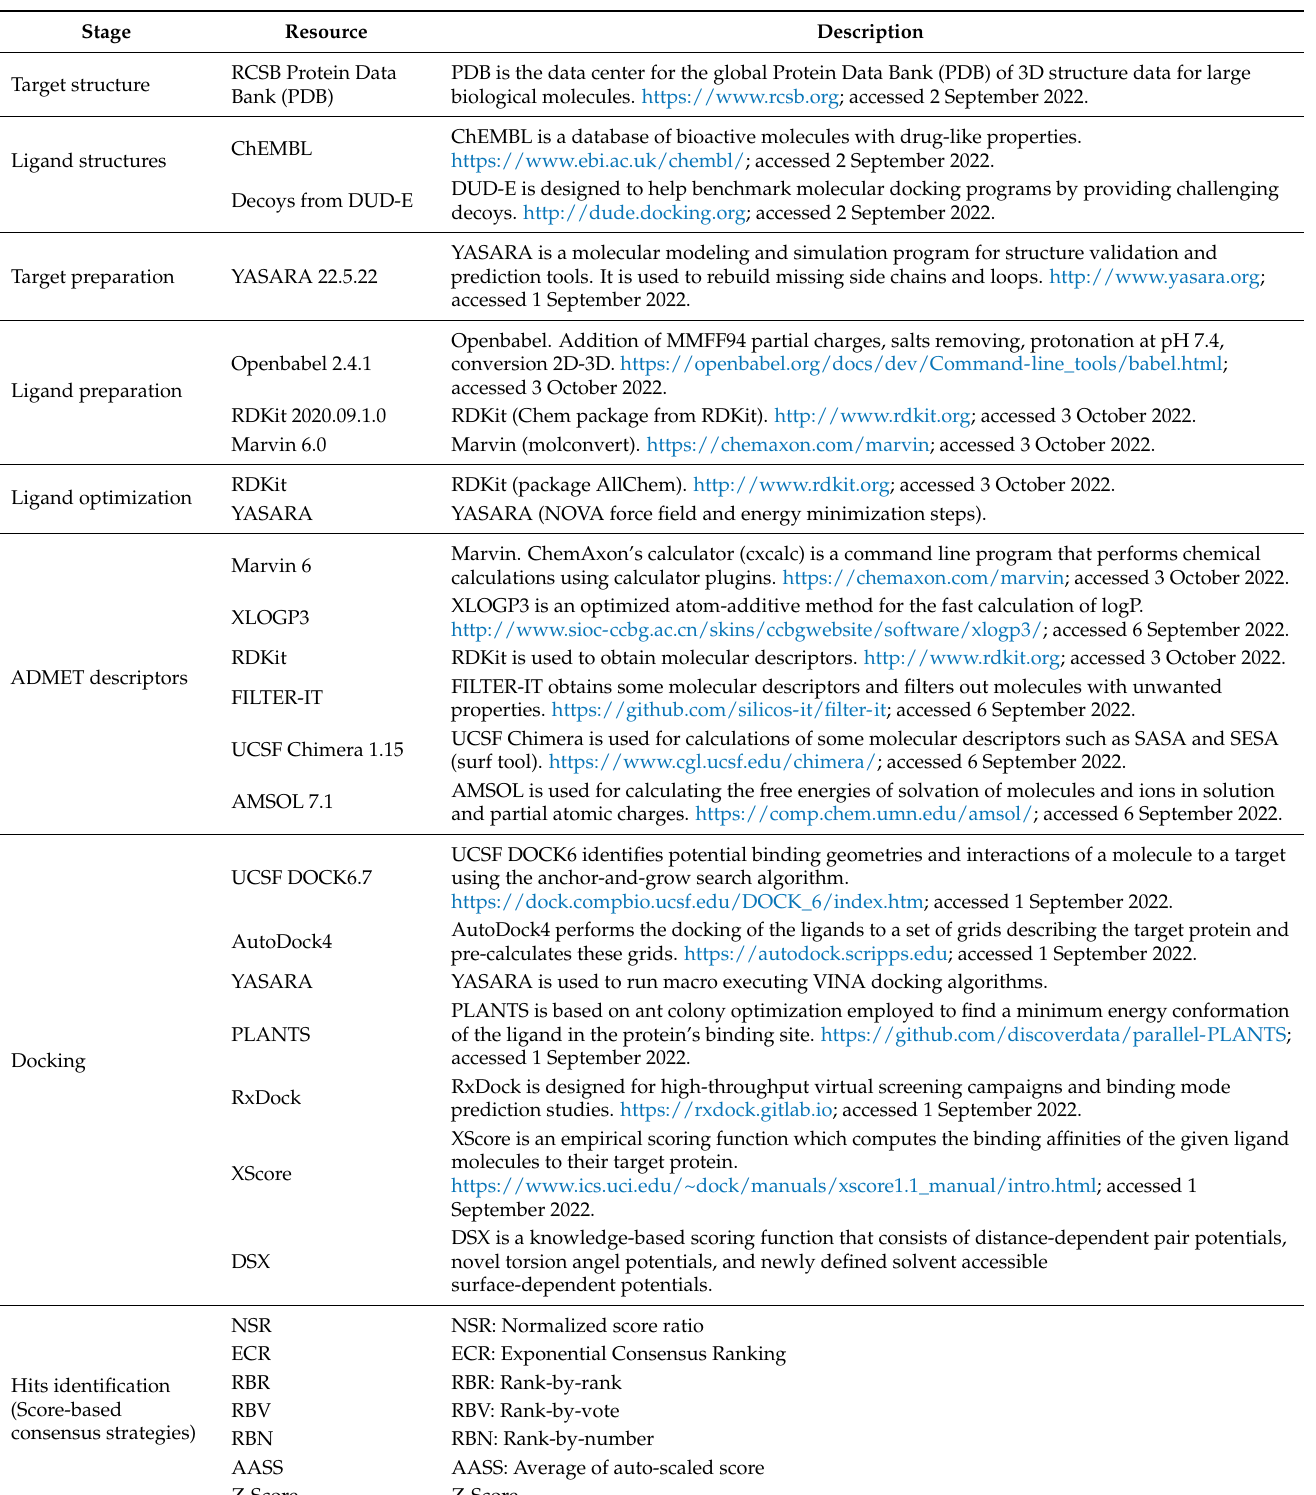
Table 2. Resources used in the screening workflow for